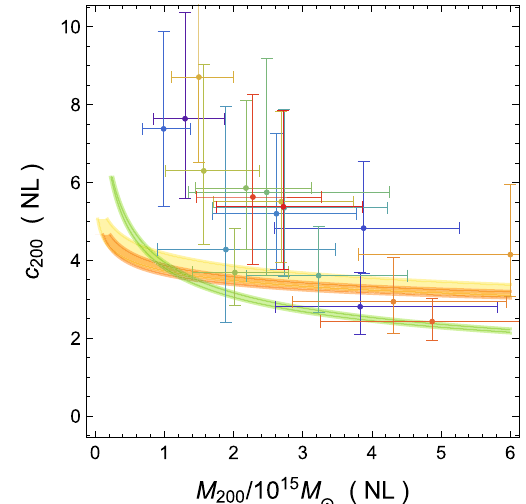
point and, as a result, the MCMC sampling is concentrated in this specific area.